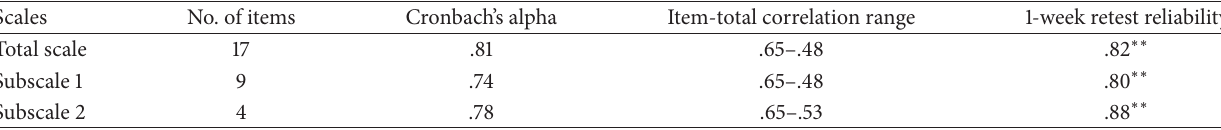
Table 4: Internal consistency and one-week retest reliability of the PPCB